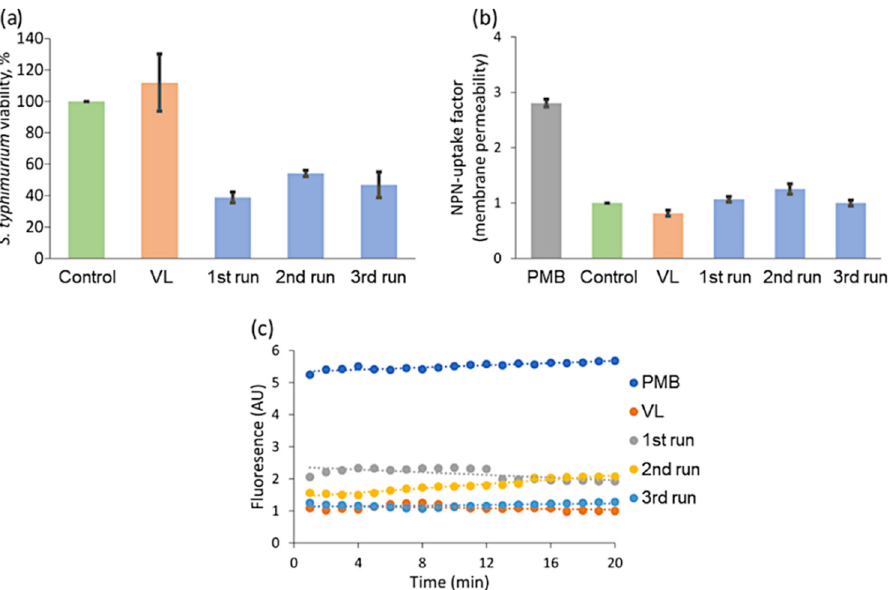
Figure 11. S. typhimurium bacteria photocatalytic inactivation experiments with visible-light irradi- ation: ( a ) viability, ( b ) membrane permeability, and ( c ) ethidium fluorescence. tion: ( a ) viability, ( b ) membrane permeability, and ( c ) ethidium